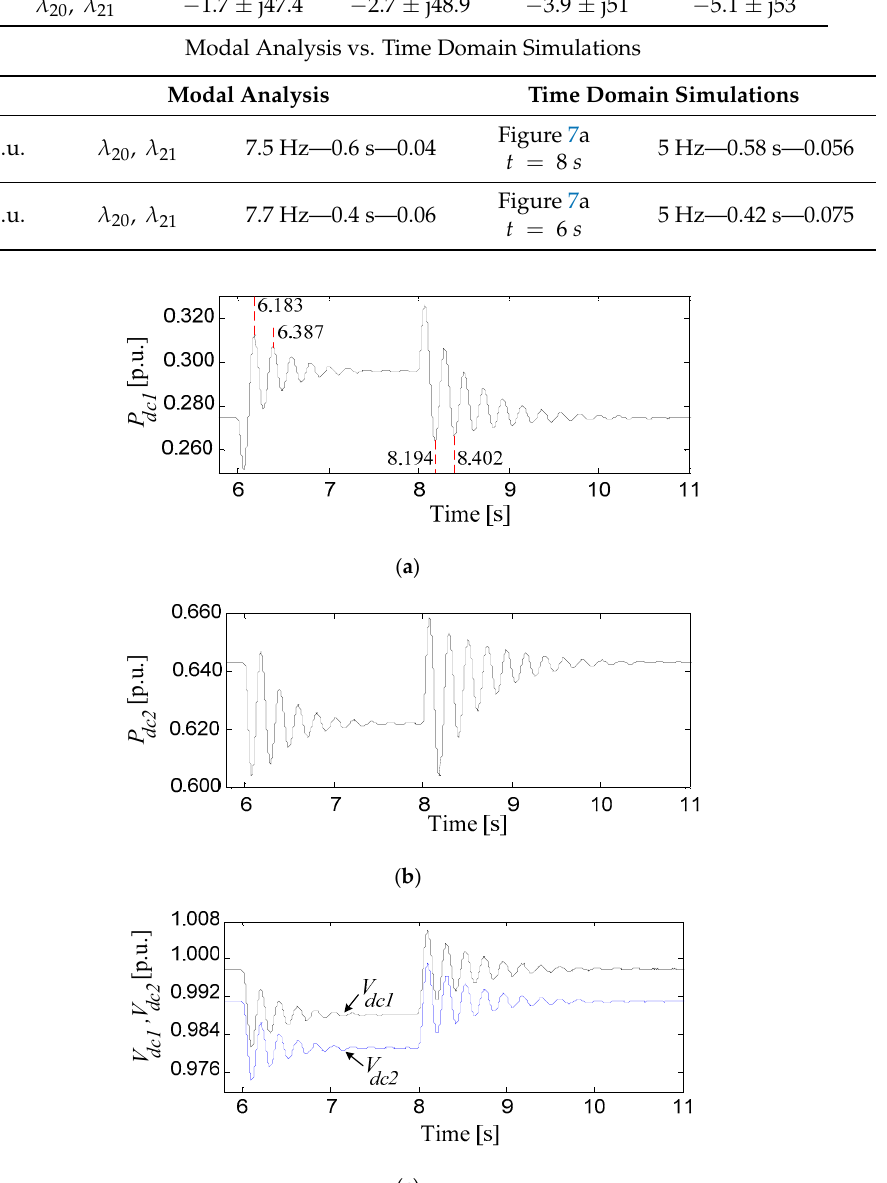
Figure 6. System response to a step change in the static droop gains for both VSRs from 1 to 5 and 5 to 1 p.u. at t = 6 and 8 s, respectively. ( a ) Injected dc power from VSC1; ( b ) Injected dc power from VSC2; ( c ) DC-link voltages at VSCs 1 and